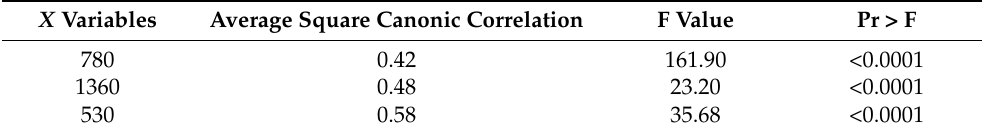
Table 6. Results of stepwise selection carried out on DNA categories and reflectance data X in the range of 350–2500 nm. X